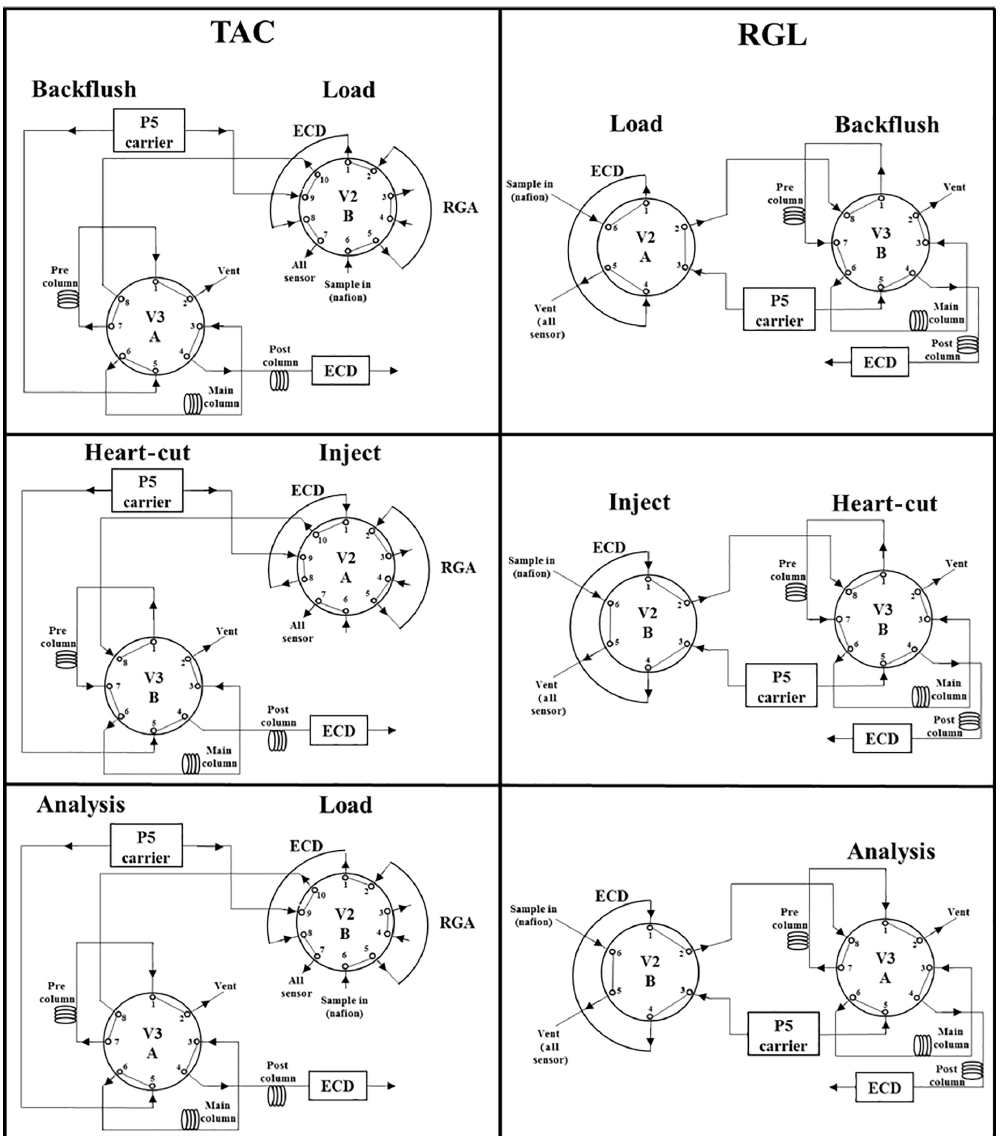
Figure 3. ECD frontend valve configuration for sample backflush, heart cut and analysis at Tacolneston (TAC) and Ridge Hill (RGL). The MHD setup is outlined in Prinn et al.